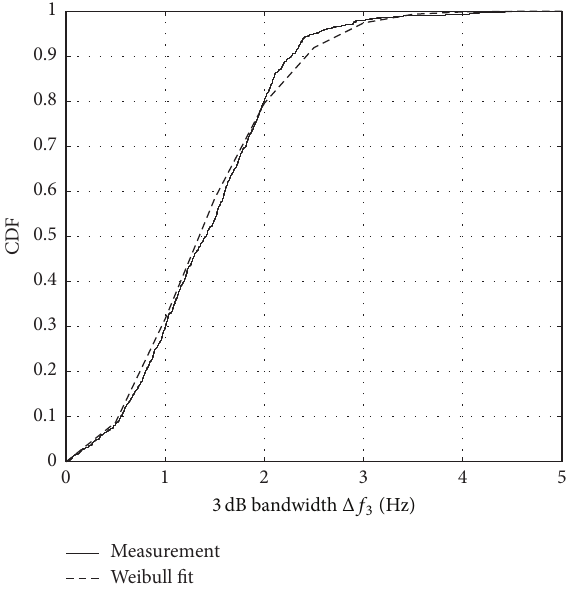
Figure 15: CDF of the estimated 3 dB bandwidth of MPCs for Scenario-1, compared with the Weibull fit. The 𝑝 value obtained by the KS test is